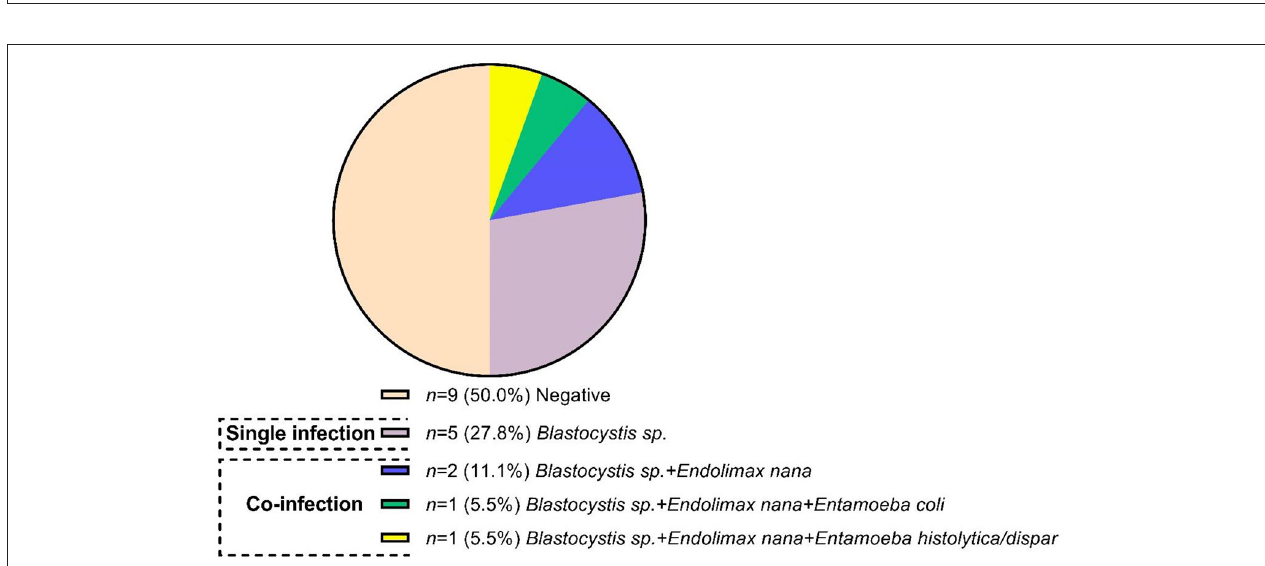
FIGURE 1 | Graphical distribution of intestinal protozoa cysts. (A) Blastocystis sp .; (B) End. nana ; (C) Ent. coli ; (D) Ent. hystolytica/dispar ; (E) coinfection ( Blastocystis sp. and End. nana ); (F) coinfection multiple ( Ent. hystolytica/dispar , End. nana, Blastocystis sp.). Micrometric coefficient: 2.5 µ m (A,C–F) ; 1 µ m (B) .